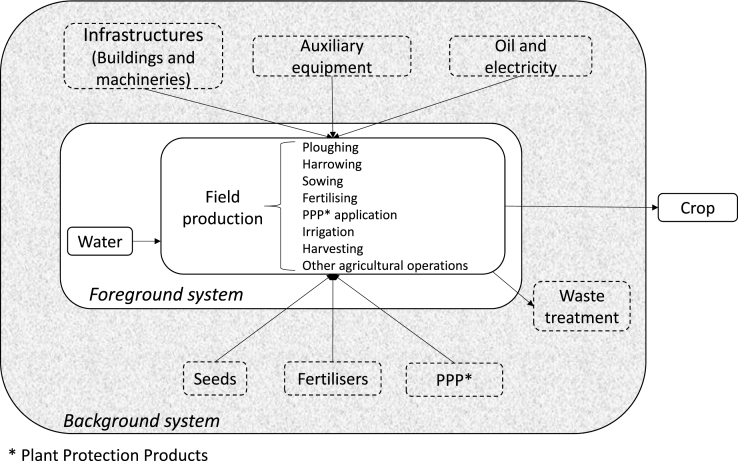
Representation of agricultural production systems. Adapted from Hayashi et al. (2006).